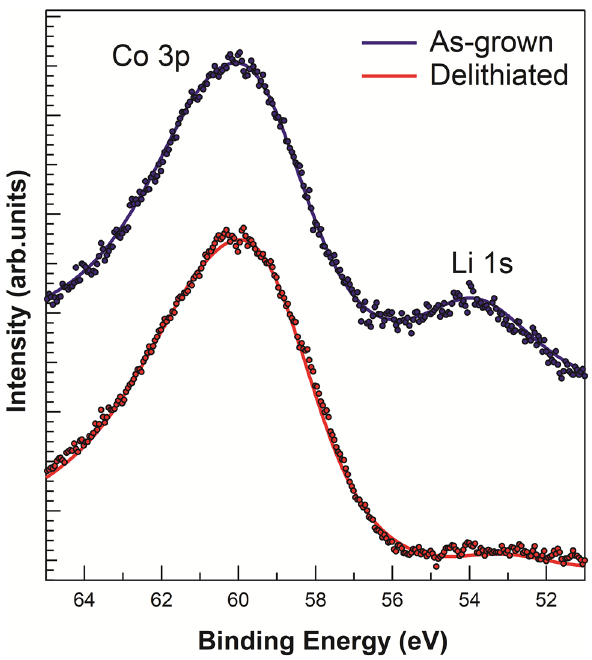
Figure 9. XPS Co 3p and Li 1s regions for the as-grown (top) and chemically delithiated (65 min at 10 –2 M oxalic acid, bottom) samples. Dots are experimental data and the line serves as a guide to the